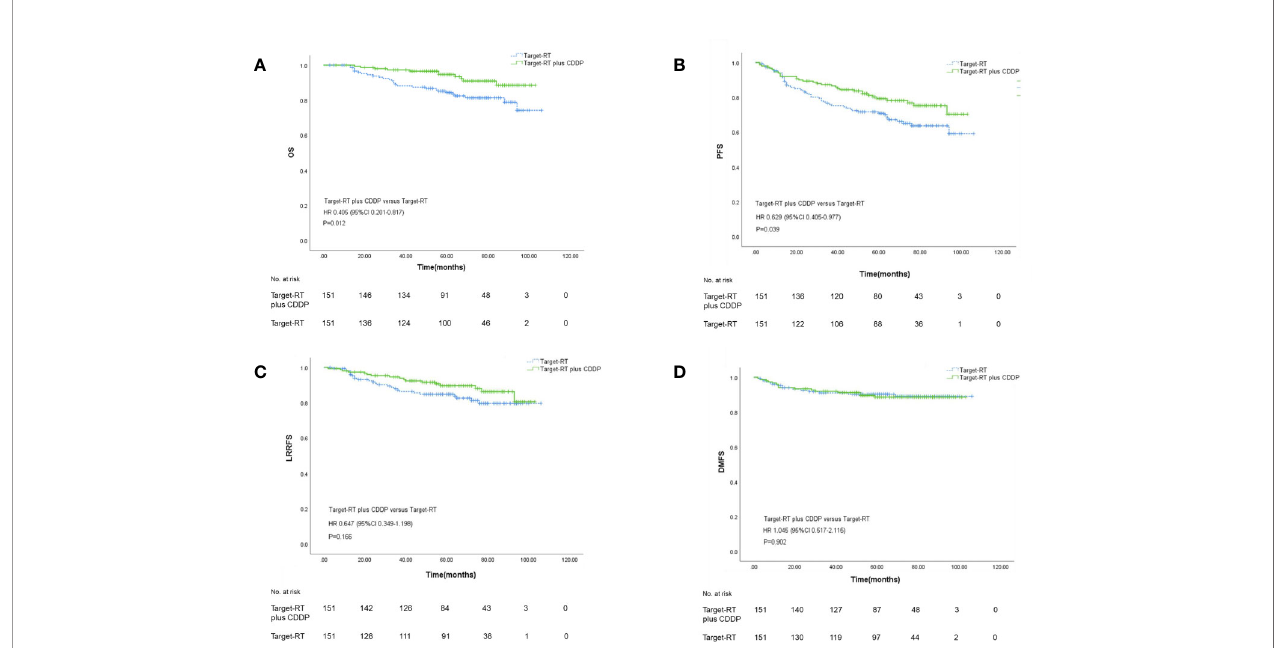
FIGURE 2 | Kaplan – Meier curves of overall survival (A) , progression – free survival (B) , locoregional recurrence-free survival (C) , and distant metastasis-free survival (D) according to Target-RT plus CDDP or Target-RT treatment in the 302 well-balanced